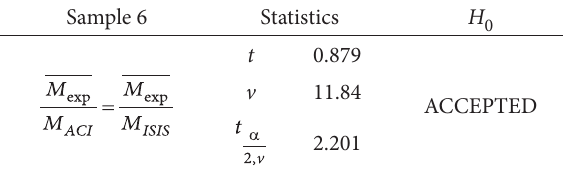
Table 6. Results of t test of sample 6 Sample